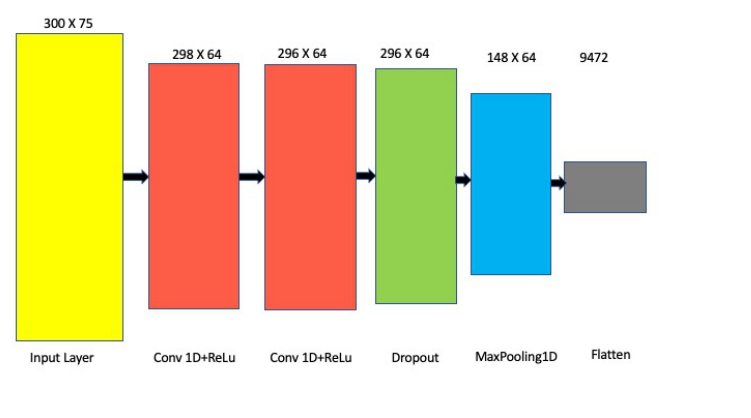
Figure 7. Architecture of the 1D-CNN block used. The same architecture is used in both blocks 1 and 2 shown in Figure